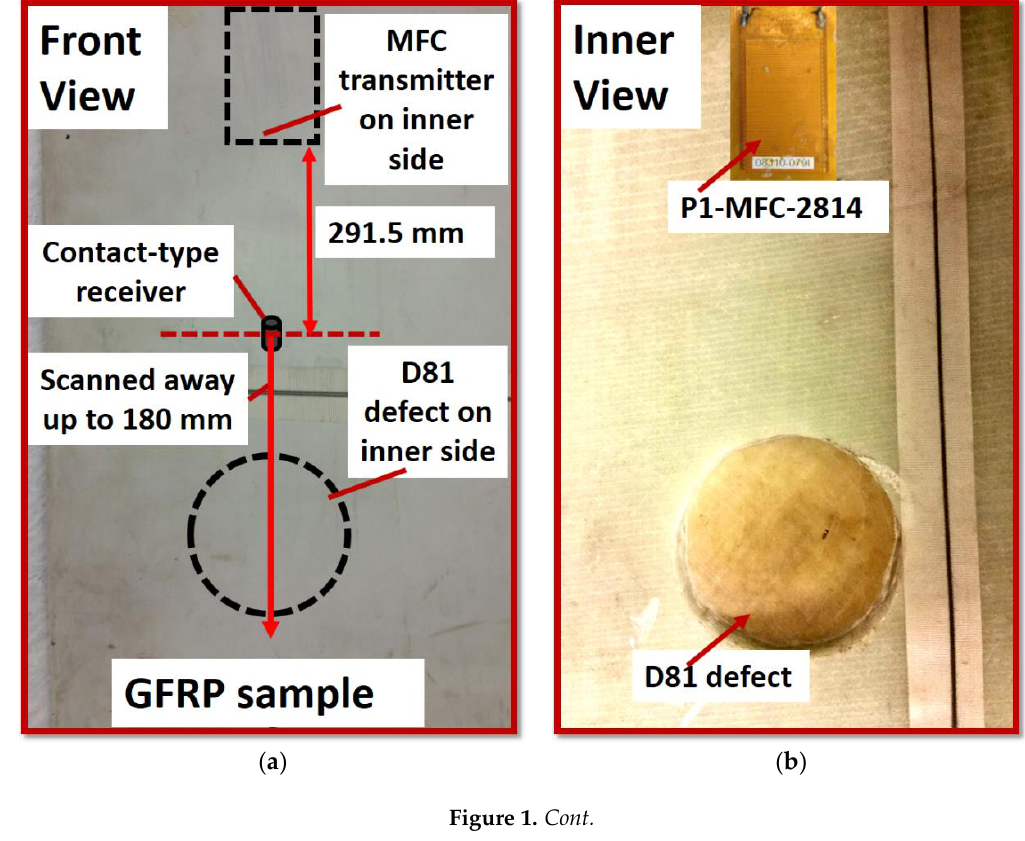
Table 1. Parametric specifications of LF ultrasonic